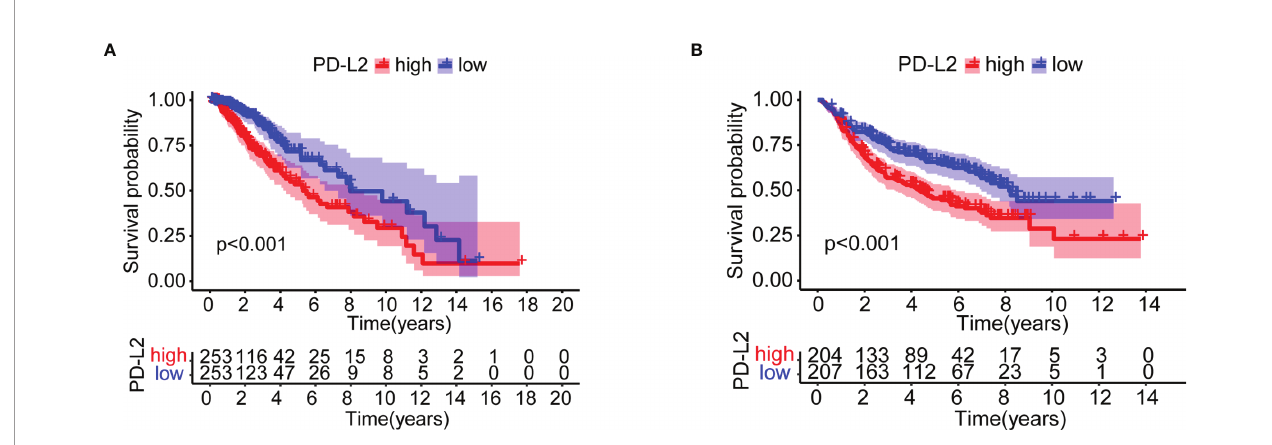
FIGURE 3 | Kaplan – Meier overall survival (OS) curves for patients in the TCGA (A) and CGGA (B) datasets assigned to high- and low-expression